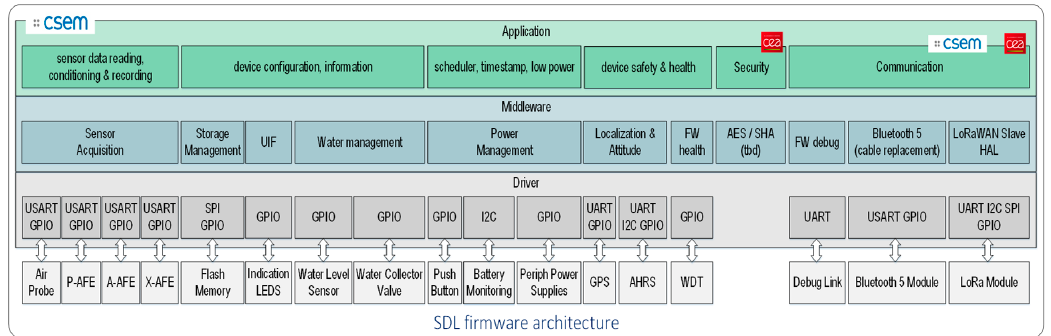
Figure 11 . The Smart Data Logger and PV cell in the support, b-support fixed to the soil . Figure 11. The Smart Data Logger and PV cell in the support, b-support fixed to the soil.